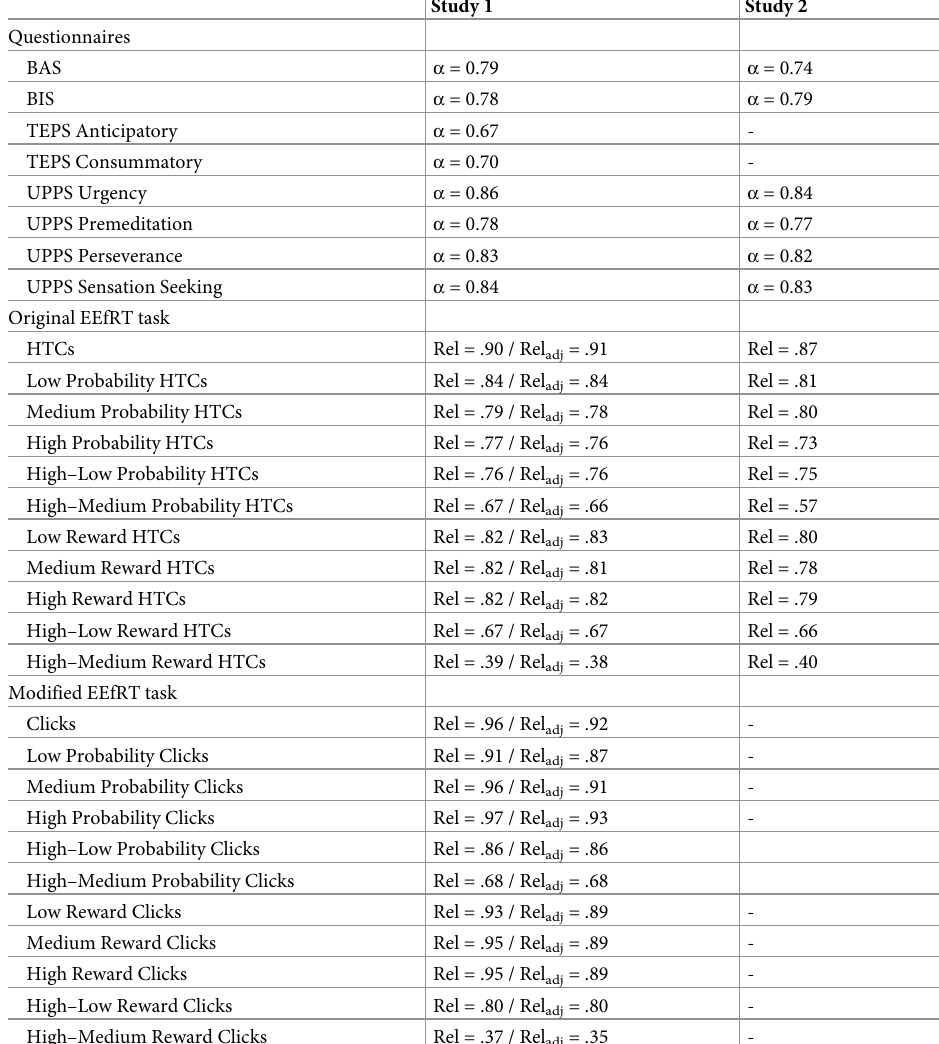
Table 2. Internal consistencies and reliabilities for questionnaires and both versions of the EEfRT in Study 1 and 2.